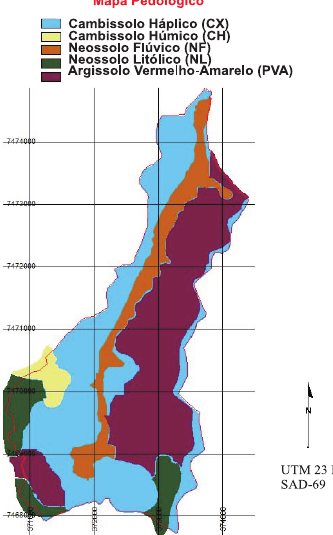
Figura 2. Distribuição das classes de solo da sub- bacia das Posses. Fonte: Silva et al.